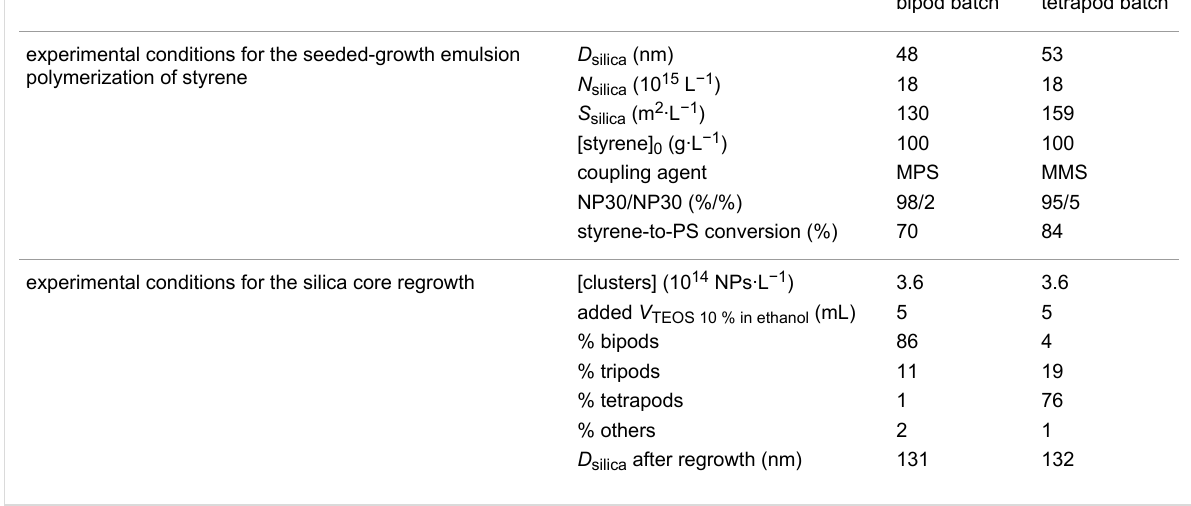
bipod batch tetrapod